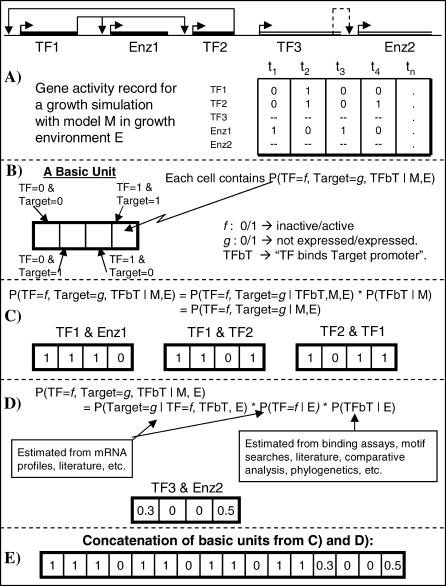
A Graphical Depiction of How an Activity Profile Is Created for a Growth SimulationThe example model M in (A) contains genes for three transcription factors and two enzymes and shows the 0/1 (“off/on”) state of each gene in each time step tn of a simulation for a defined growth environment E. The dashed line in the model indicates that a regulatory connection between the two genes is not explicitly modelled, but is suspected to exist.(B) shows how a “basic unit” is defined and shows the general formula for the parameterization of each cell. One basic unit exists for every known or suspected TF–target gene pair.As shown in (C), for such regulatory connections explicitly modelled, each cell of the basic unit gets either a “0” or a “1,” depending on whether its associated transcription factor and target gene were observed to be in the indicated 0/1 combination in any simulation time step.(D) illustrates how the inferred TF–target gene regulatory connections and logic derived from experimental and/or computational data are incorporated in a basic unit.In (E) the basic units from (C) and (D) are concatenated to form the activity profile for the simulation.